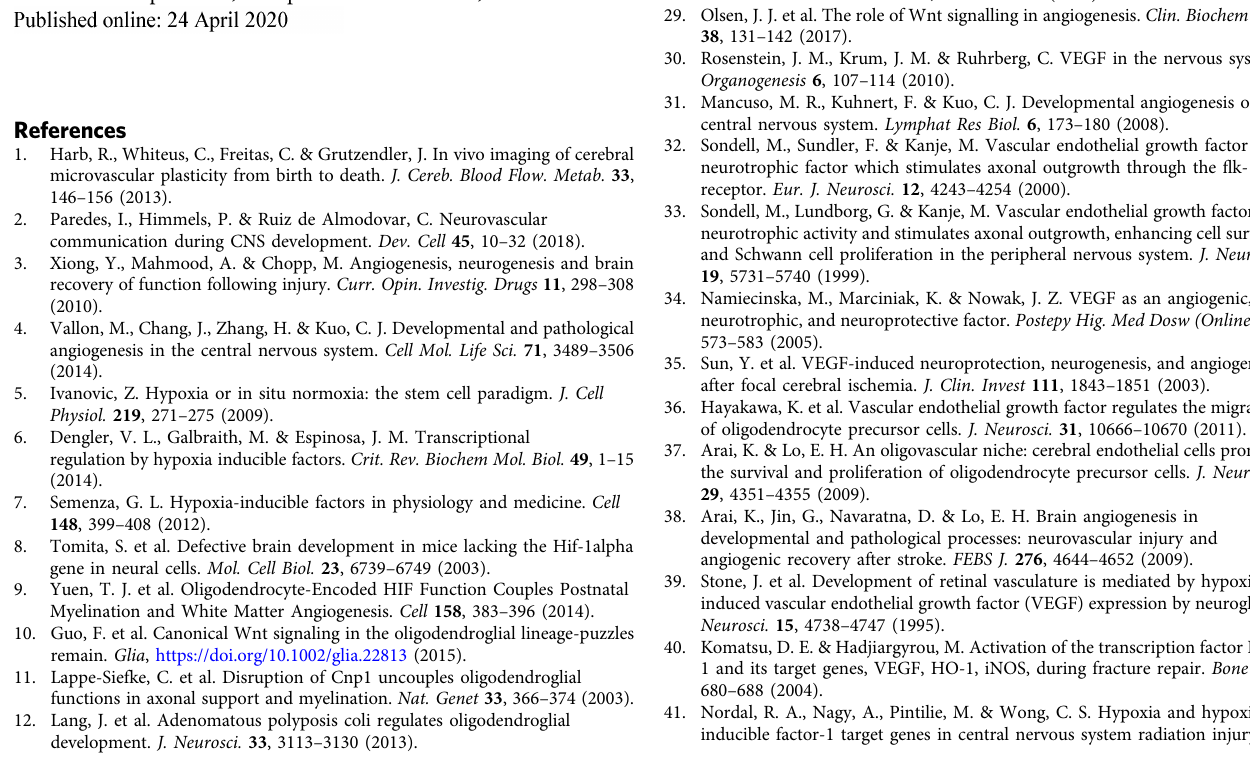
Statistical analyses . Quanti fi cation was performed by blinded observers. All measurements were taken from distinct mice and quantitative data are presented